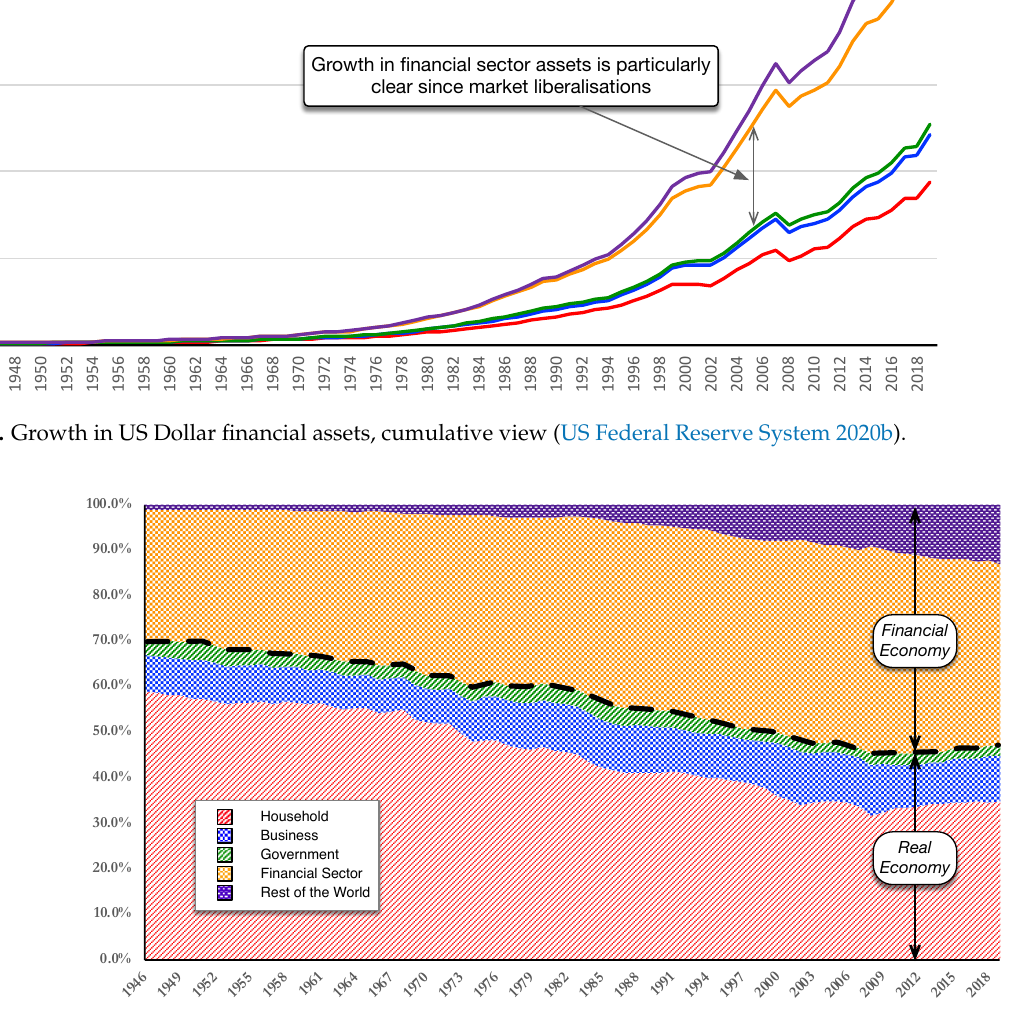
Figure 2. Cumulative % share of US financial assets by sector (US Federal Reserve System